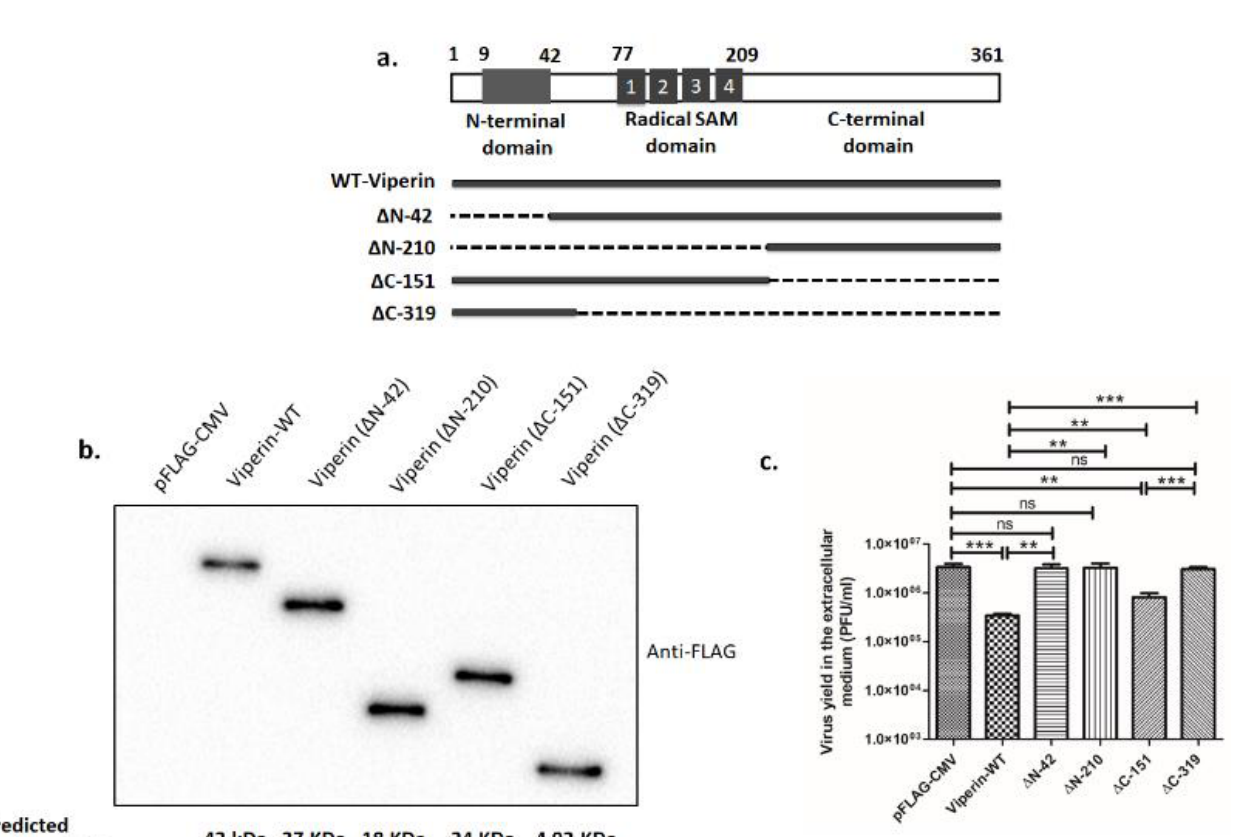
Figure 3. Full-length viperin was indispensable to prevent rotaviral egress from the infected cells. ( a ) Schematic repre- sentation of the structures of the viperin and its mutants used in the study. Residues 9–42 constituted the N-terminal amphipathic α -helix (depicted in gray), which was required for its localization to the cytosolic face of the ER and lipid droplets. The radical SAM domain (residues 77-209) containing four conserved motifs (marked in gray) was essential for its functional activities. The conserved C-terminus was involved in dimerization, but no other functions have yet been ascribed to it. ( b ) Expressions of the FLAG-tagged wild-type viperin and its four mutants in HEK-293 cells. ( c ) HEK-293 cells overexpressing either wild-type viperin or viperin mutants were infected with RV-SA11 at an MOI of 3 and incubated for 24 h. After incubation, extracellular mediums were collected and used to measure viral yield by plaque assay. Data represent mean virus particles ± SD of three independent experiments; *** represents p ≤ 0.001, ** represents p ≤ 0.01, ns represents p value non-significant, unpaired S tudent’s t -test.